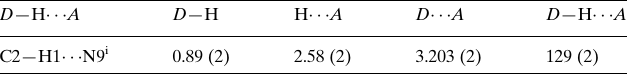
Hydrogen-bond geometry (A˚ , (cid:2)